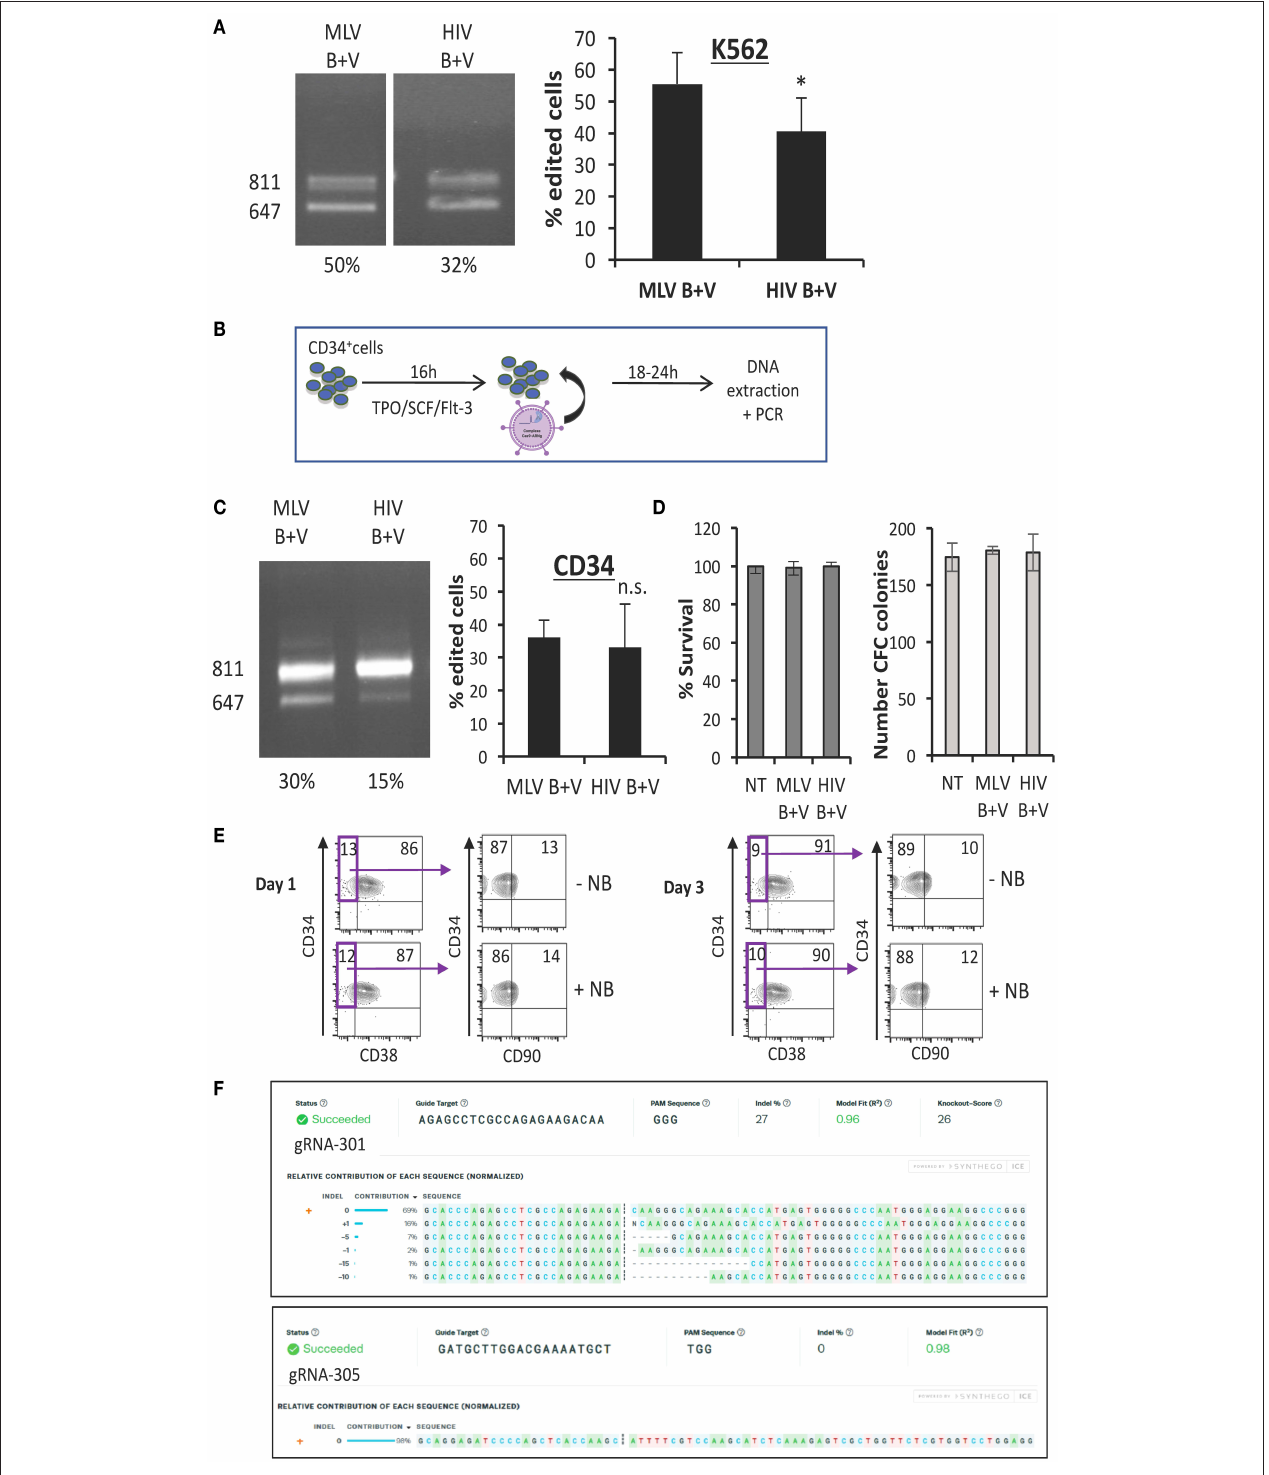
FIGURE 5 | Nanoblades permit efficient gene-editing in human K562 cells and CD34 + cells. (A) K562 cells transduced with MLV- or HIV-based nanoblades co-pseudotyped with BaEV- and VSVG-gps (B + V). Electrophoresis gel of the PCR product using WASFw/WASRv primers with the % gene-editing indicated for each lane (left) and summarizing graph showing percentage of gene editing (right) (means ± SD; (MLV B + V n = 7, HIV B + V n = 6; student t -test, * p < 0.05). (B) Schematic presentation of protocol used for CD34 + cells. CD34 + cells were activated with cytokines (TPO/SCF/Flt-3) for 16h, then nanoblades were added and